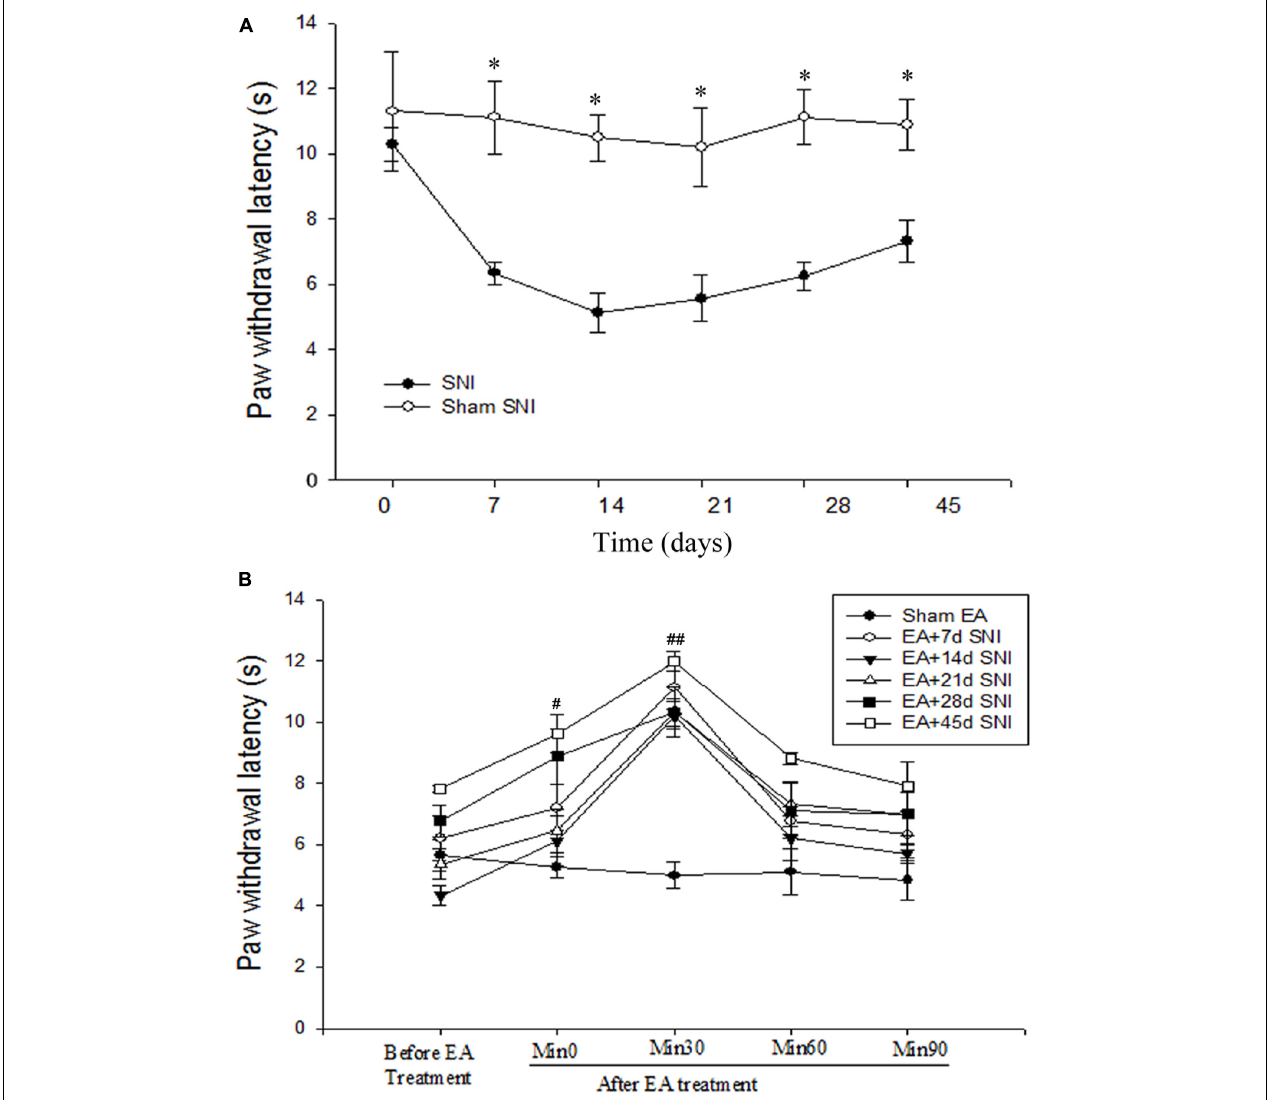
FIGURE 1 | Immediate antihyperalgesic effects of EA at the different stages of spare nerve injury (SNI). (A) Thermal hyperalgesia during 45 days after the SNI operation. ∗ p < 0.01. (B) Immediate effects of single EA on thermal hyperalgesia during the different stages of SNI. # p < 0.05; ## p < 0.01 vs. PWL scores before EA stimulation. There were no significant differences in PWL scores before and after Sham EA ( p >